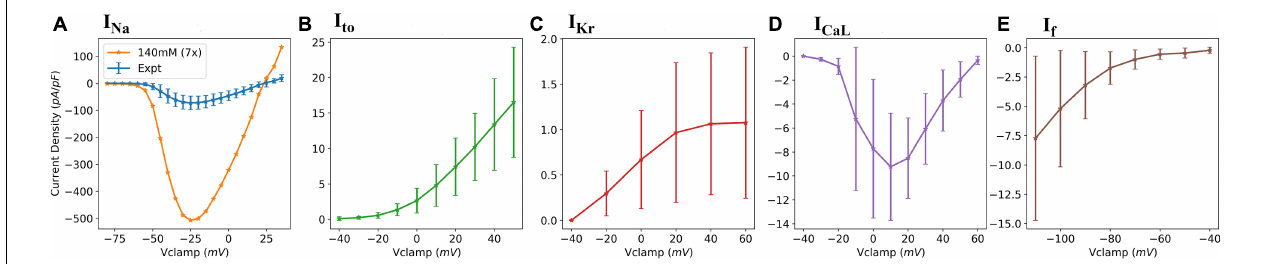
FIGURE 1 | Experimental data IV plots. (A) fast sodium current ( I Na ); (B) transient outward potassium current ( I to ); (C) delayed rectifier potassium current ( I Kr ); (D) L-type calcium current ( I CaL ); and (E) Hyperpolarization-activated current ( I f ). The errors bars represent the experimental standard deviations from multiple cell